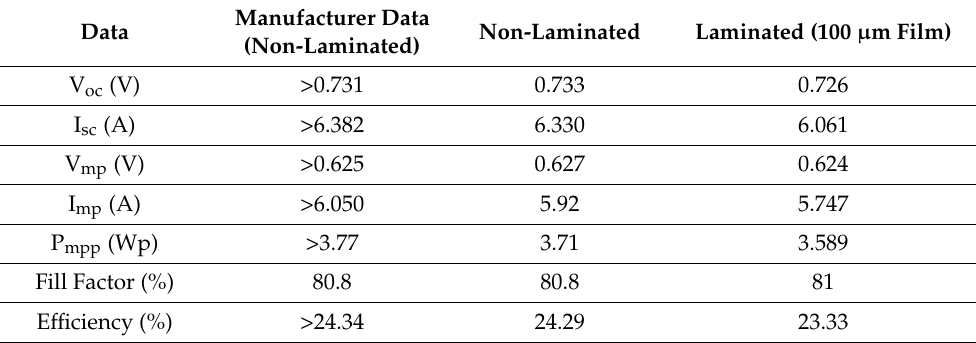
Table 3. Electrical specifications of tested SunPower Maxeon Ne3 solar cells.